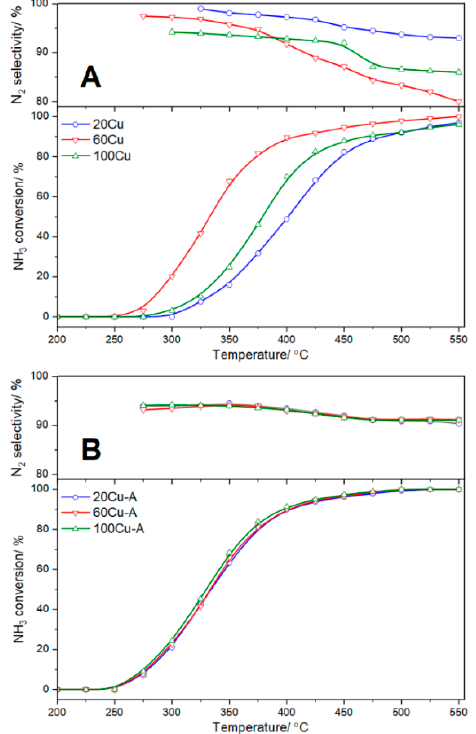
Figure 11. Temperature dependence of the ammonia conversion and N 2 selectivity in process of ammo- nia oxidation for the Al-S-MCM-41 sample modified with copper by TIE ( A ) and TIE-NH 3 ( B ) methods.